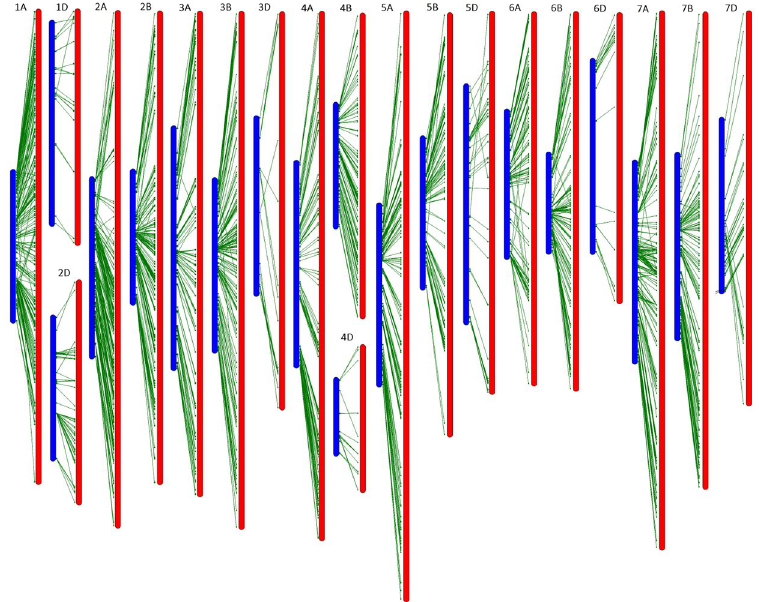
Figure 5. Synteny of the mapped SNPs from the Wheat660K SNP array (in blue ) with that from the Wheat90K array (in red ) based on their common CSS-assembled contigs.